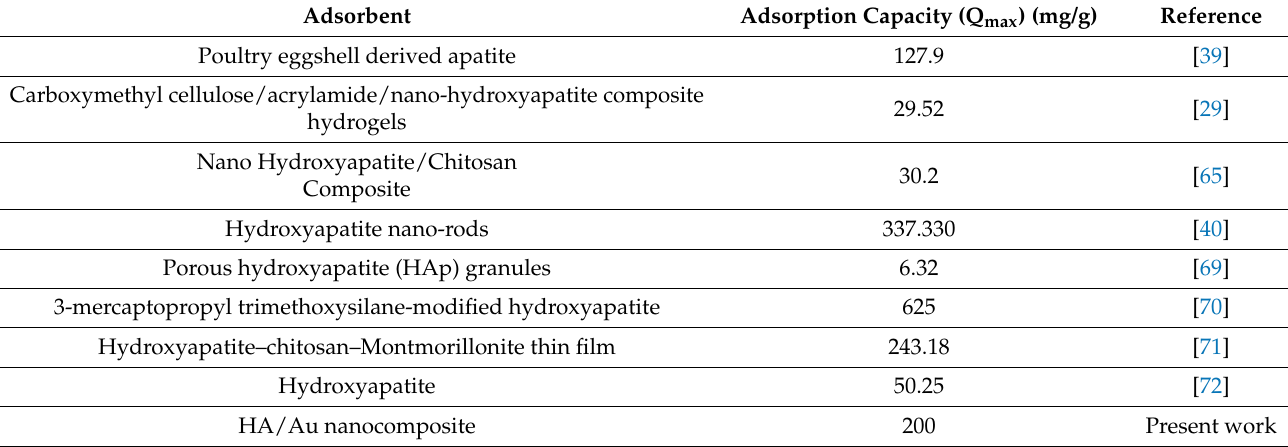
Table 3. Comparison of various adsorbents with hydroxyapatite for the removal of the dyes from aqueous media. Adsorbent Poultry eggshell derived